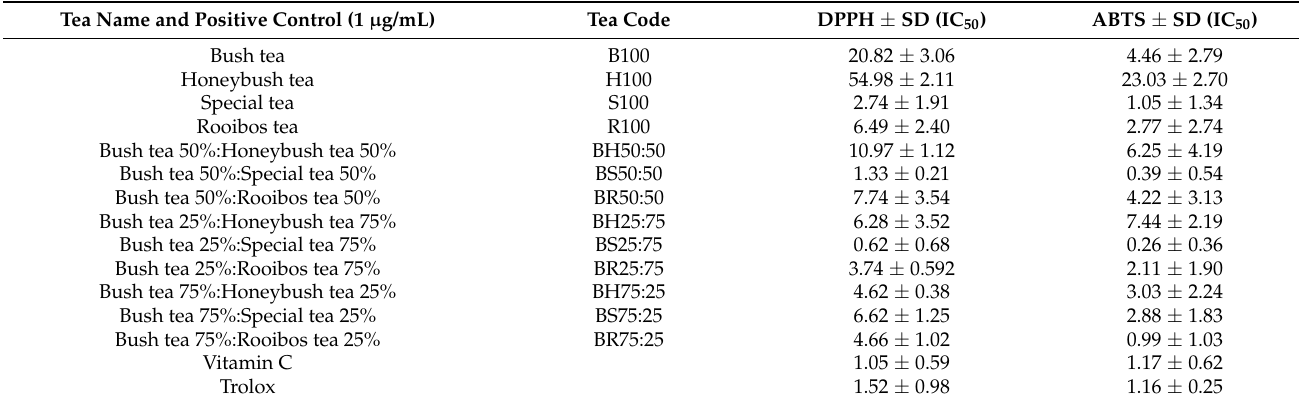
Table 1. Anti-oxidant activity of selected herbal teas assessed using DPPH and ABTS decolourisation